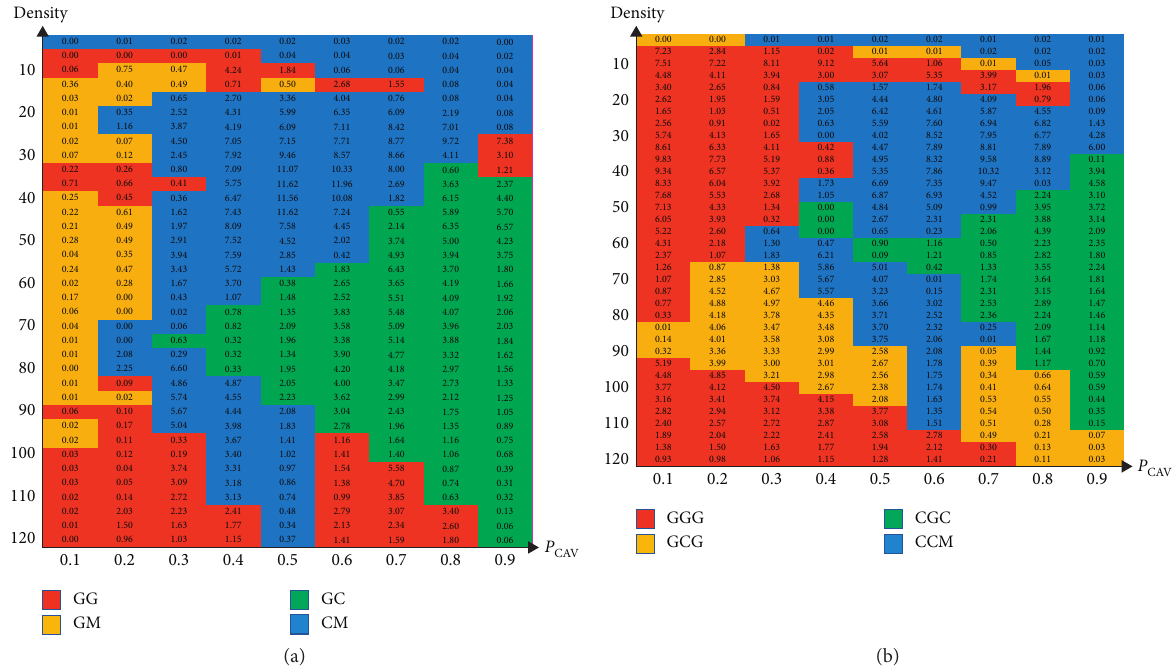
Figure 4: (a) Diagram of best lane policies in terms of average speed (two-lane freeways). (b) Diagram of best lane policies in terms of average speed (three-lane